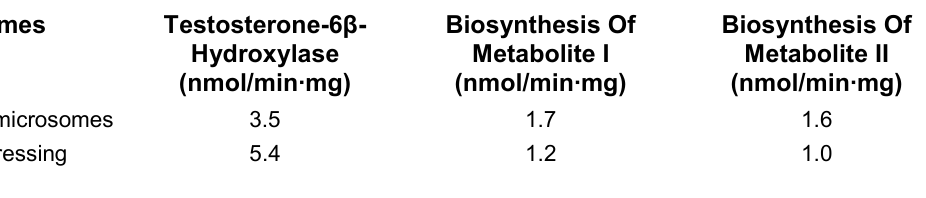
Comparison of Human Liver Microsomes and CYP3A4 Expressing Supersomes